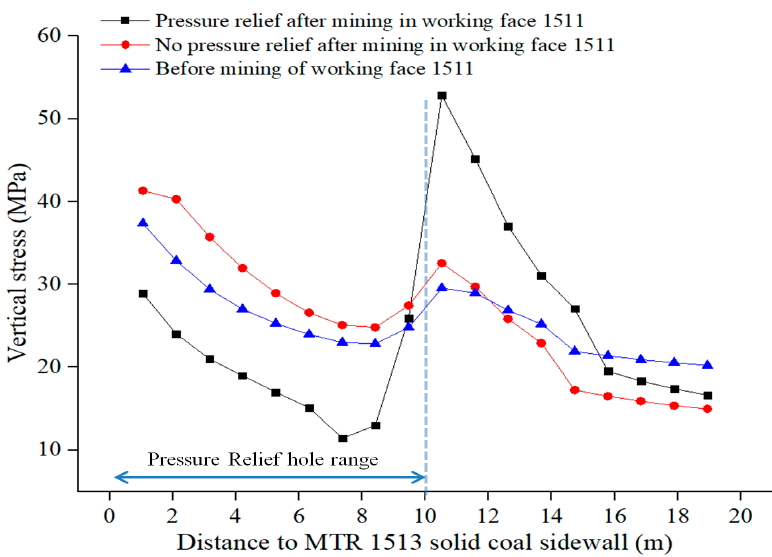
Figure 7. Comparison of vertical stress of solid coal side roof of MTR 1513 before and after pressure relief.